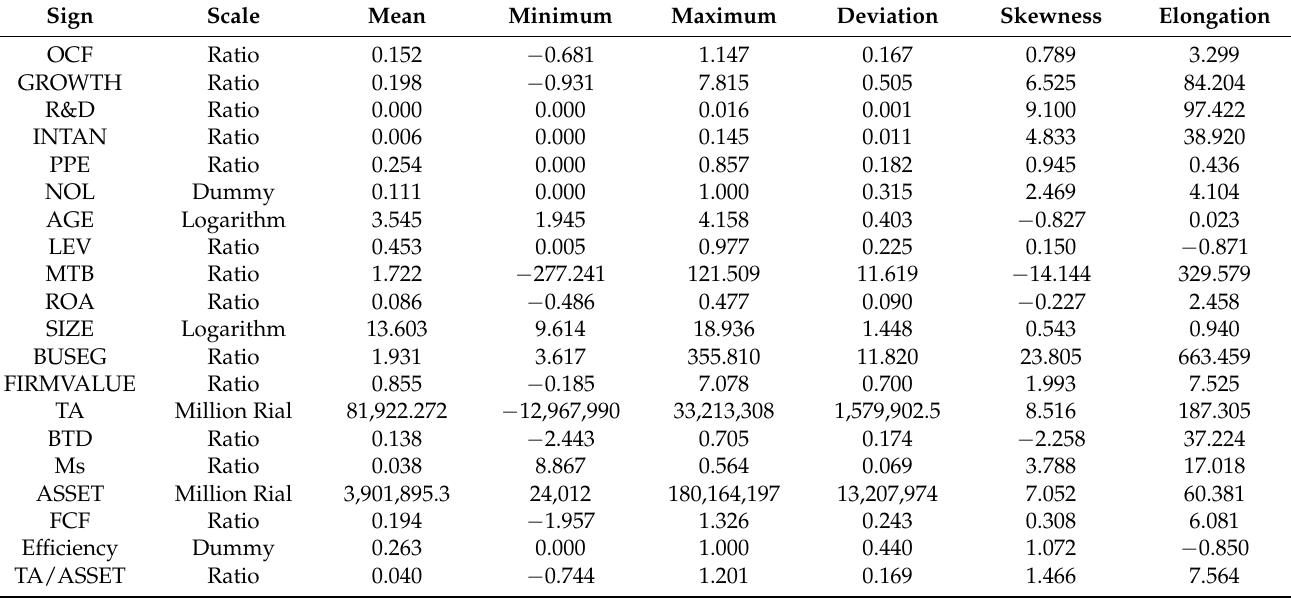
Table 1. Descriptive statistics of research